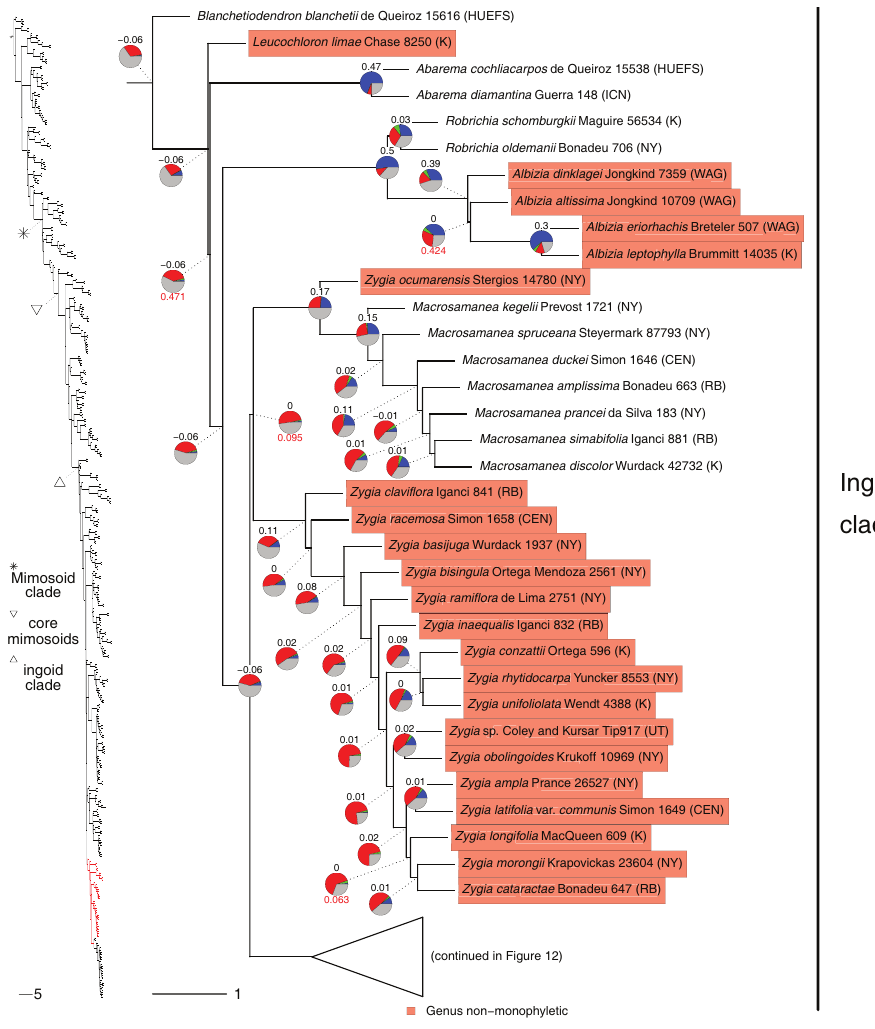
Figure 11. Phylogeny of Caesalpinioideae (continued). See Fig. 2 for